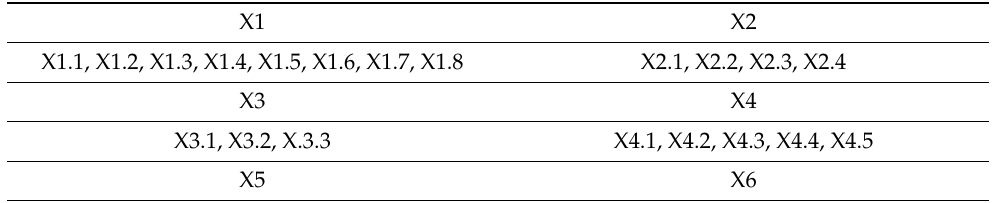
Table 4. Multi-input–output